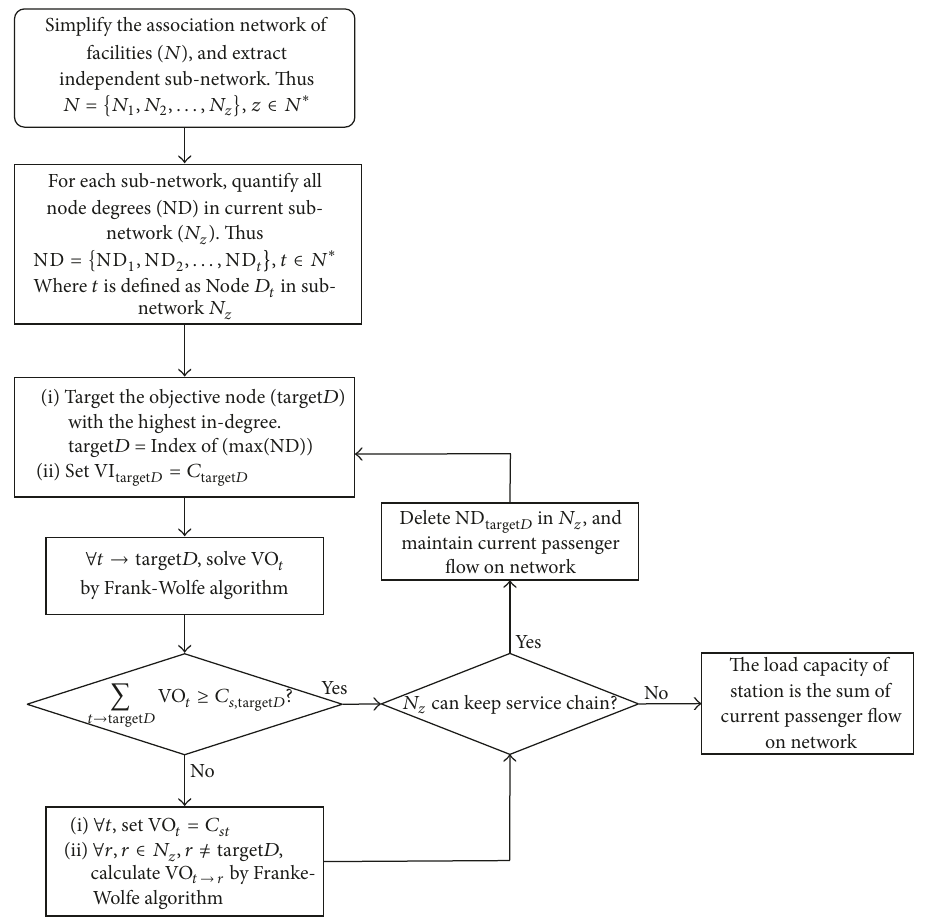
Figure 3: The flow chart of algorithm for calculating load